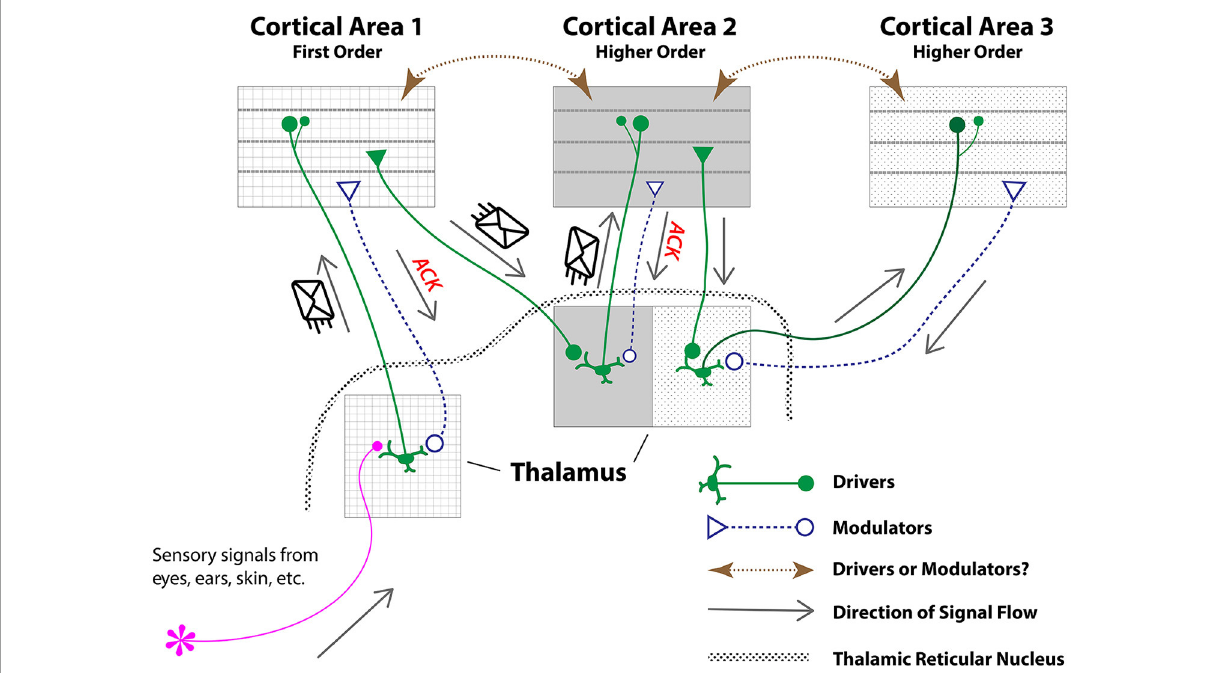
FIGURE3 A schematic, hypothetical model under which thalamic relays provide ACKs over the “higher-order relays” organization of thalamo-cortical circuits (Sherman and Guillery, 1998, 2001, 2002). Under the scheme proposed in the current paper, messages containing “content” are sent by “driver” neurons, while “modulators” return ACK-like messages back to thalamic senders, either directly or by way of the thalamic reticular nucleus. If the driver’s message is delivered successfully, modulator ACK messages would prevent resending. If a timely ACK is not received, a driver in thalamus could be triggered to resend the missing message. Note that an ACK sent from cortex to thalamus confirming receipt implicitly confirms that the message successfully traveled on an earlier leg from cortex to thalamus (since thalamic excitations are seen as signals relayed from elsewhere), perhaps obviating the need for ACKs on the earlier leg. Figure adapted from Reichova and Sherman (2004). Given the comparatively large distances traveled between cortex and thalamus and the possibility of spike failure (which is more common in long axons), as well as other types of message loss or corruption, some system of delivery verification would seem appropriate for this core of the brain network. The conventional idea that descending connections serve to “adjust the weights” of incoming signals (e.g., as a way to modulate attention) does not explain why long loops to the thalamus would be required—weights could in principle be adjusted by local circuits in cortex itself, without the cost, delay, and risk of making a long projection back to the thalamus. Instead, this architecture appears better suited to flexible and verifiable message passing among cortical areas via the thalamus. Cortico-thalamo-cortical communication in the Sherman and Guillery picture is thought to be mediated by two parallel links that go in opposite directions: (1) “driver” connections originate in higher-order thalamic nuclei, traveling to higher-order cortical areas (drivers are also considered to include projections from first-order thalamic relays, such as LGN, to first-order cortical areas, such as V1, and projections from layer 5 of first-order cortical areas to higher-order thalamic relays, such as pulvinar); (2) “modulator” projections originate in layer 6 of the areas targeted by higher- order thalamic relay drivers, and descend to the thalamus to synapse onto the dendritic arbors of drivers (Sherman and Guillery, 1998, 2001, 2002). 3 Drivers form a minority of inputs but are seen to deliver primary messages. Modulators are much more numerous, and can affect the likelihood of transmission of driver signals but do not seem to alter the content of those signals (e.g., they do not change receptive field properties of first-order thalamic relays from LGN to V1; Reichova and Sherman, 2004). Modulators also connect to the thalamic reticular nucleus, which can exert inhibitory influence on most connections between the thalamus and